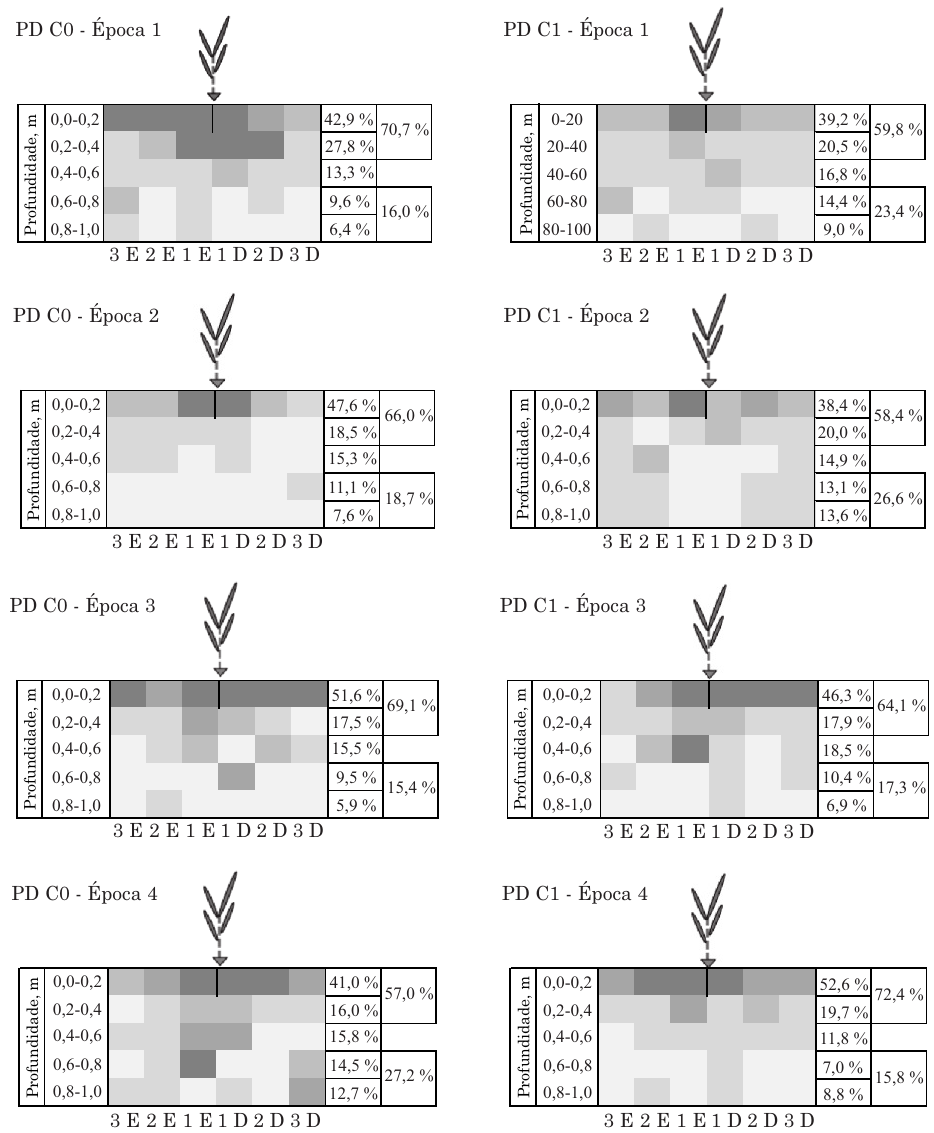
Figura 3. Distribuição do sistema radicular no sistema plantio direto (PD), por camada de solo, nas quatro épocas de amostragem: 1 - máximo deficit hídrico, 2 - início reposição hídrica, 3 - máximo excedente hídrico e 4 - início déficit hídrico, sem calcário (C0) e com 2,0 t ha -1 de calcário (C1) em seis posições: 1D - rente ao lado direito da soqueira; 2D - 30 cm à direita da posição 1D; 3D - 30 cm à direita da posição 2D; 1E - rente ao lado esquerdo da soqueira; 2E - 30 cm à esquerda da posição 1E; e 3E - 30 cm à esquerda da posição